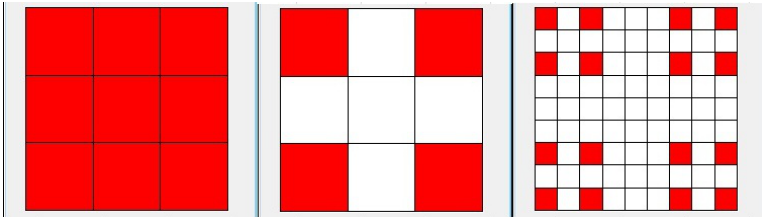
Figure 1. Fractal dimension of Cantor cubes = log 8/log 3 =